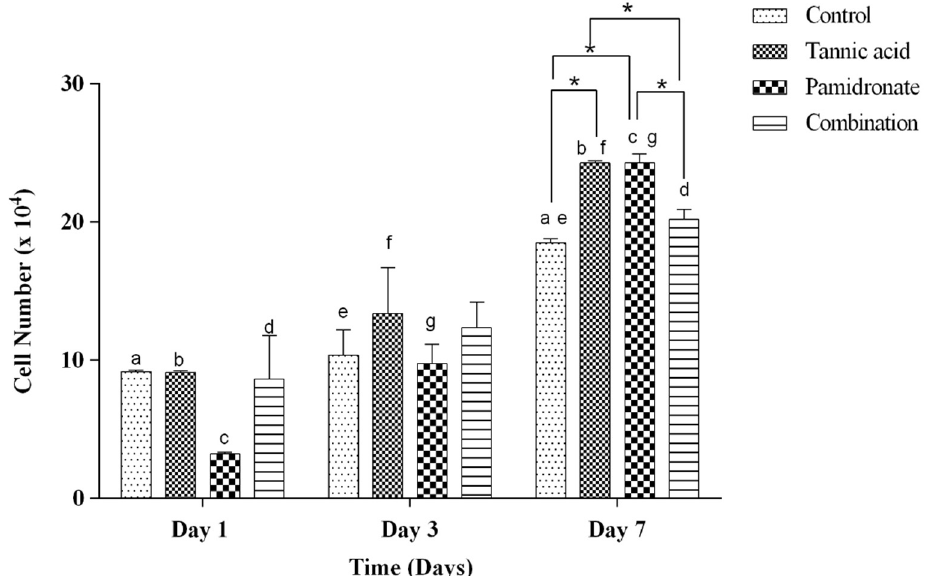
Figure 2. The number of live cells ( × 10 4 ) at Day 1, 3, and 7 in the control group (DMSO treated), tannic acid (TA)-treated group, pamidronate (PAM)-treated group, and the combination of TA and PAM (75:25) determined by Trypan blue exclusion assay. All data are shown as the mean (SEM) of three independent experiments. Days that share the same letter display a significant difference within the same group ( p < 0.05), whereas * shows a significant difference among the four groups in similar days ( p < 0.05) by one-way ANOVA and Tukey’s test.